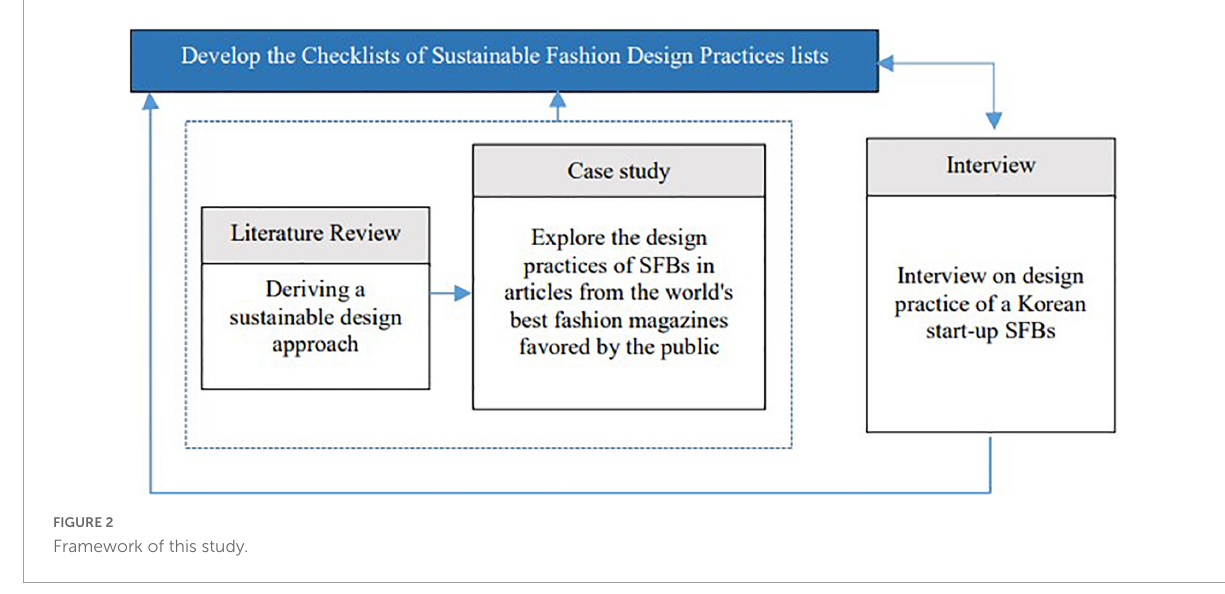
FIGURE2 Framework of this study.